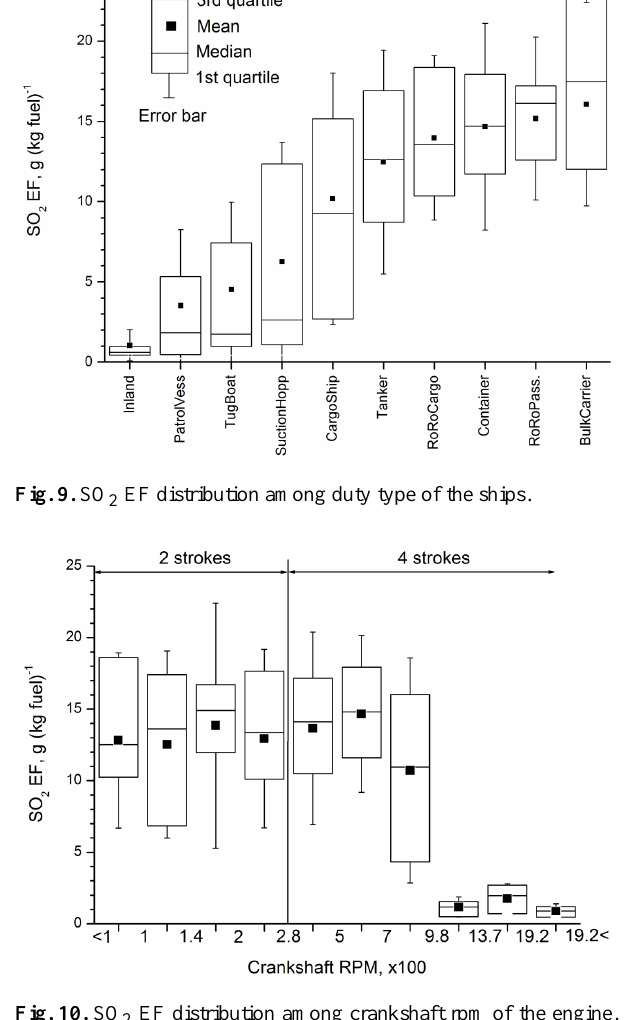
Fig. 10. SO 2 EF distribution among crankshaft rpm of the engine. The crankshaft range was divided into 11 bins based on logarithmic scale. Average SO 2 EFs of the bins are plotted along the y-axes, while sticks on the x-axes refer the borders of the bins.